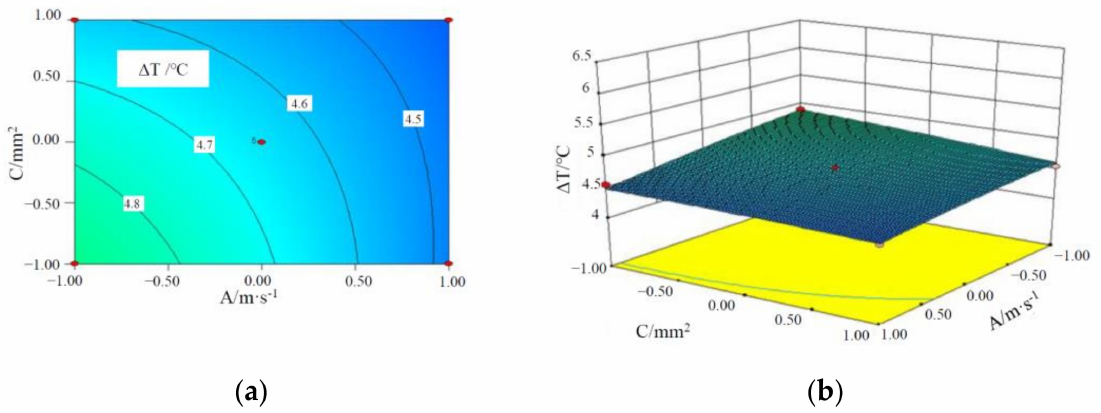
Figure 6. Contours and response surface of the impact of liquid flow rate and cross-sectional area of the pipe on the maximum temperature difference. ( a ) Contours; ( b ) response surface.